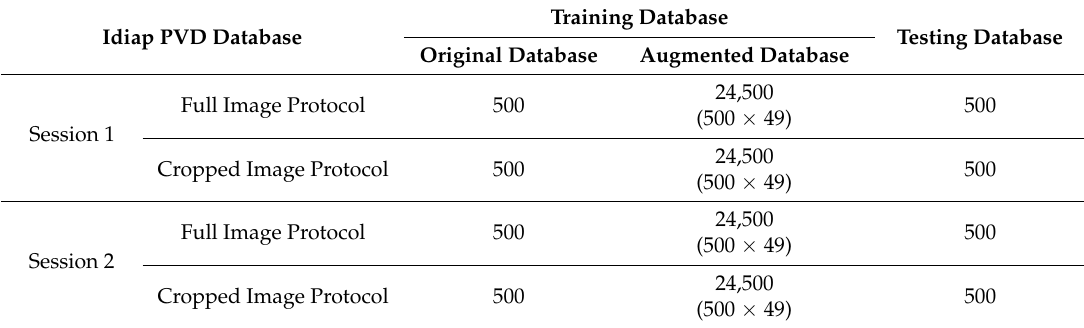
Table 23. Description of the Idiap palm-vein database (PVD) database used in our experiments for PAD for palm-vein recognition